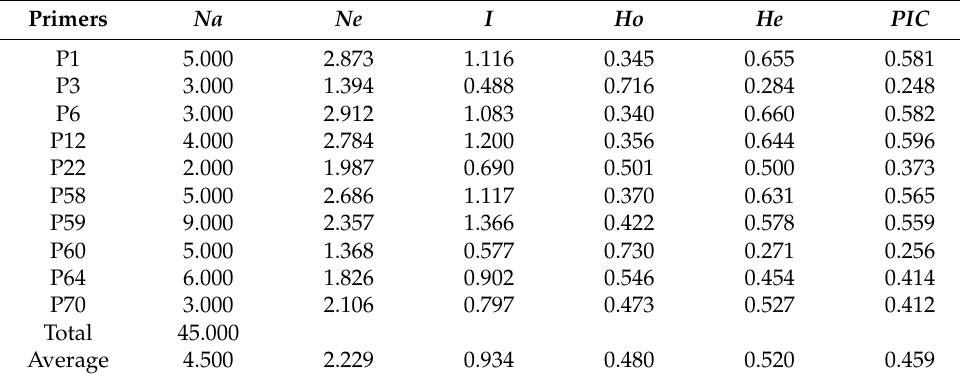
Table 3. Polymorphism analyses of 10 SSR